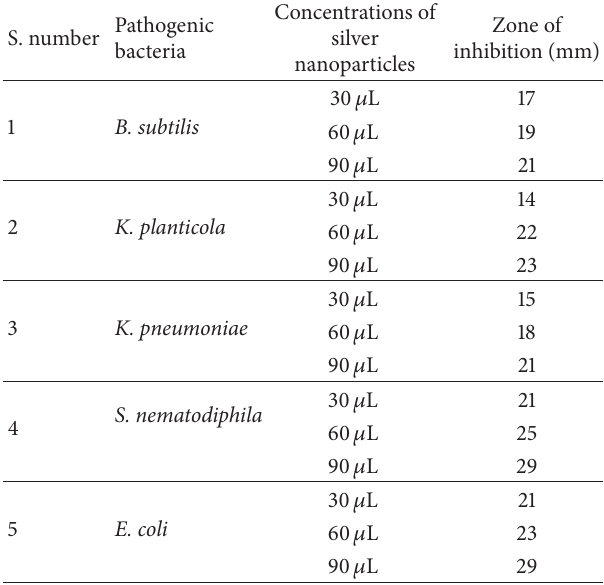
Table 1: Evaluation of antibacterial effects of silver nanoparticles against pathogenic